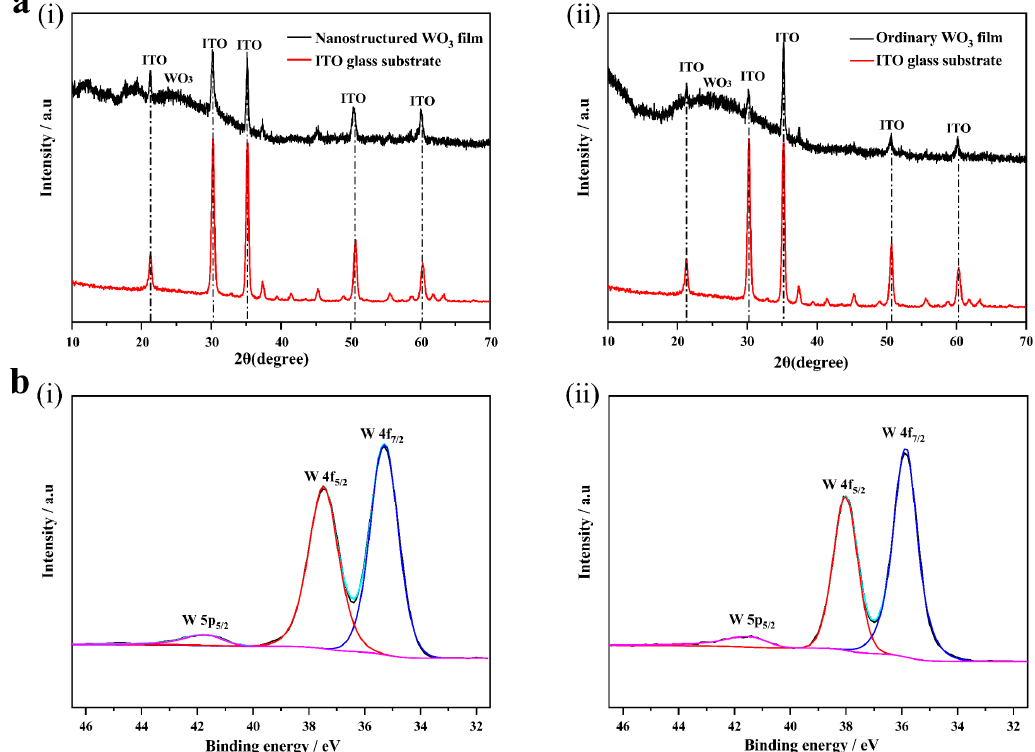
Figure 5. XRD and XPS spectra of nanostructured WO 3 film and ordinary WO 3 film. ( ai ) XRD spectrum of nanostructured WO 3 film, ( aii ) XRD spectra of ordinary WO 3 film, ( bi ) XPS spectrum of nanostructured WO 3 film, ( bii ) XPS spectrum of ordinary WO 3 film.